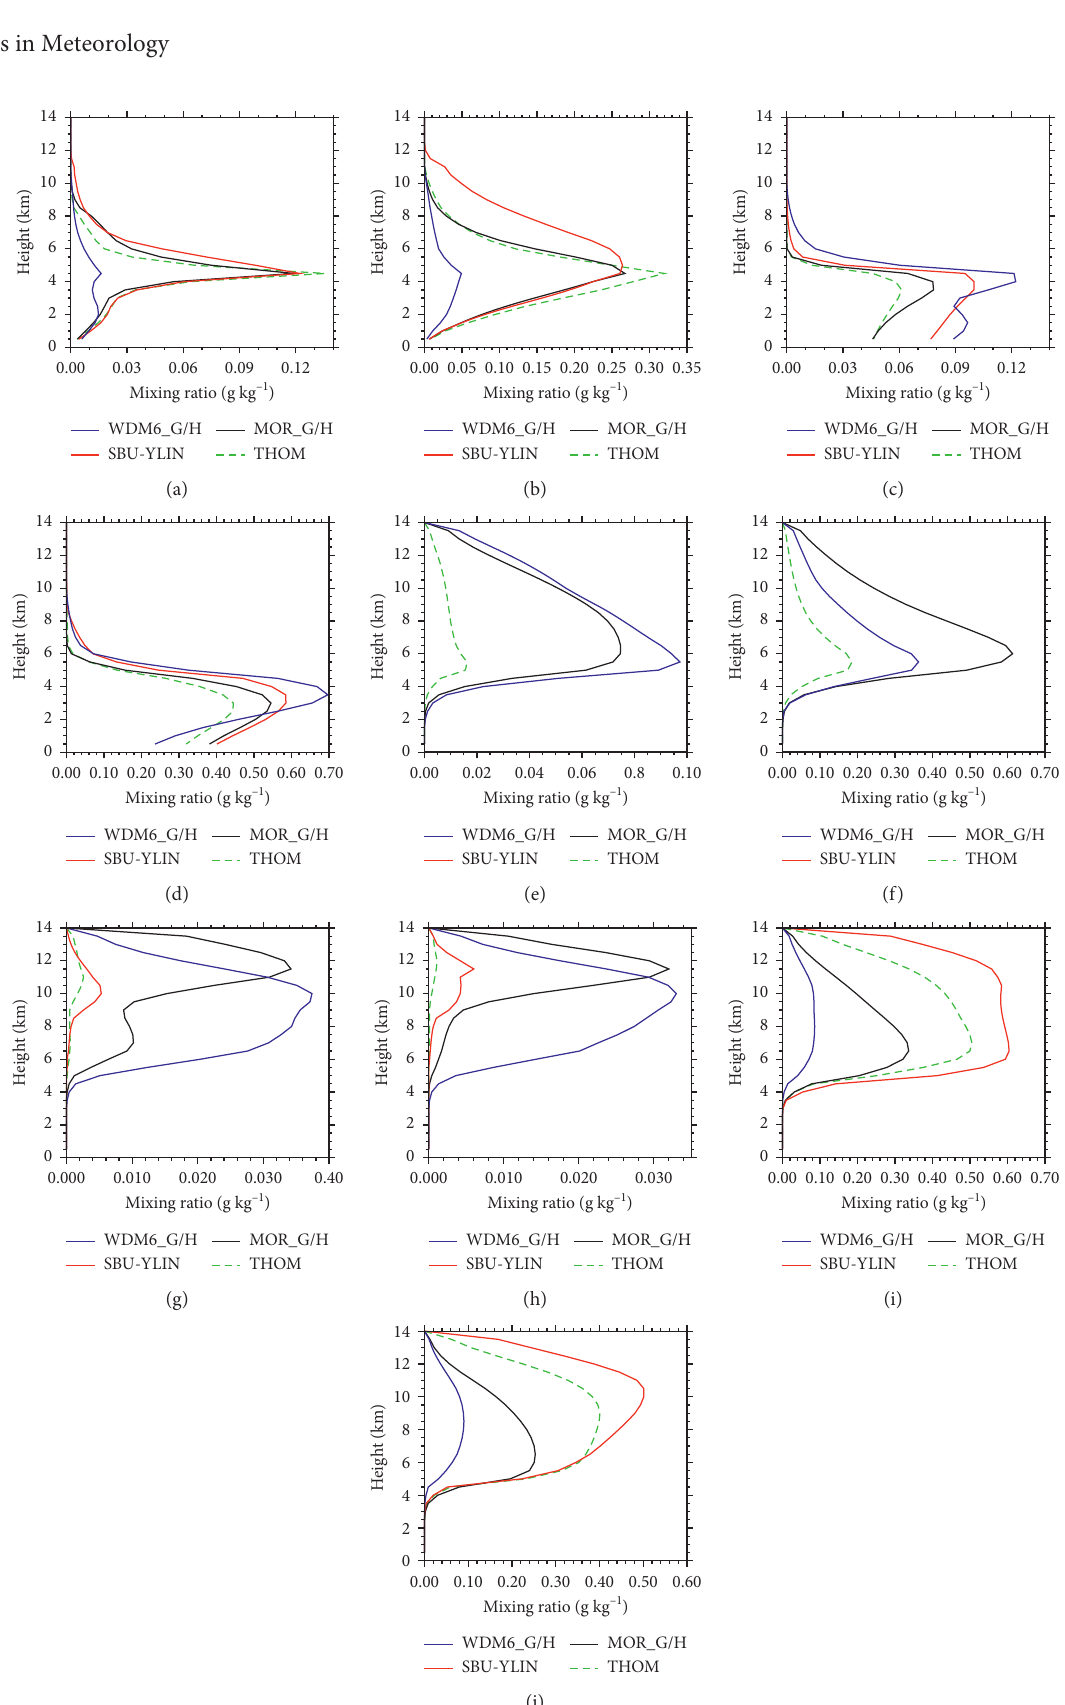
Figure 12: The time- and domain-averaged hydrometeor mixing ratio vertical profiles over the (a), (c), (e), (g), (i) stratiform and (b), (d), (f), (h), (j) convective regions for (a), (b) THOM; (c), (d) MOR_G/H; (e), (f) SBU-YLIN; and (g), (h) WDM6_G/H scheme from 0300 to 0500 UTC on 30 June 2018 within the region (107–117 ° E, 27–35 °